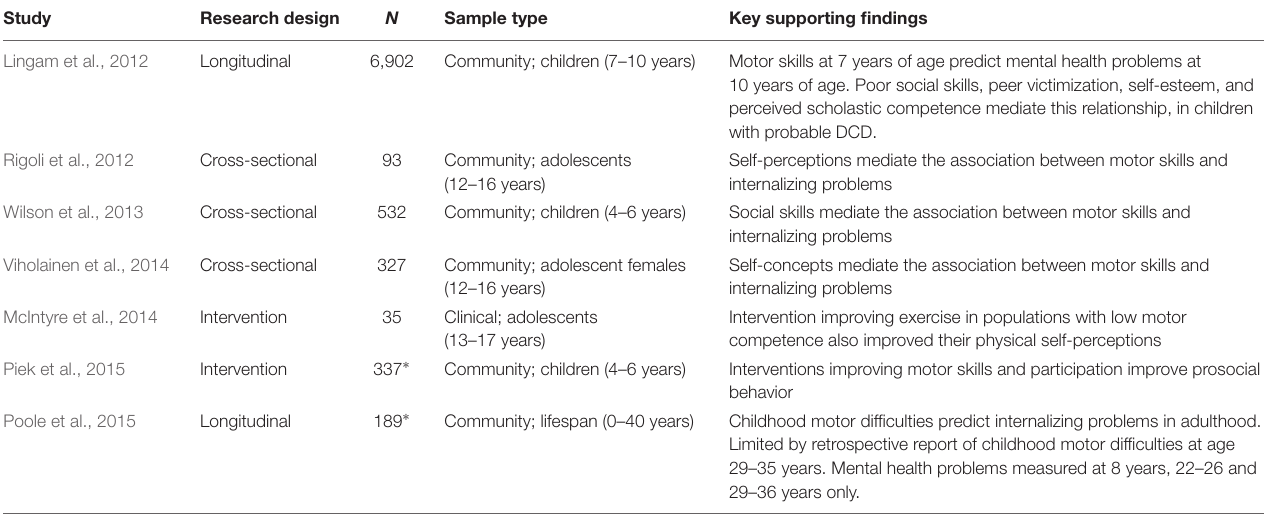
FIGURE 1 | An adapted Elaborated Environmental Stress Hypothesis. This adapted version examines motor skills across the full spectrum of ability; the original Elaborated Environmental Stress Hypothesis described by Cairney et al. (2013) specifically focused on children with developmental coordination disorder (DCD). TABLE 1 | Summary of recent, peer-reviewed empirical support for the elaborated environmental stress hypothesis by Cairney et al. (2013). Key supporting